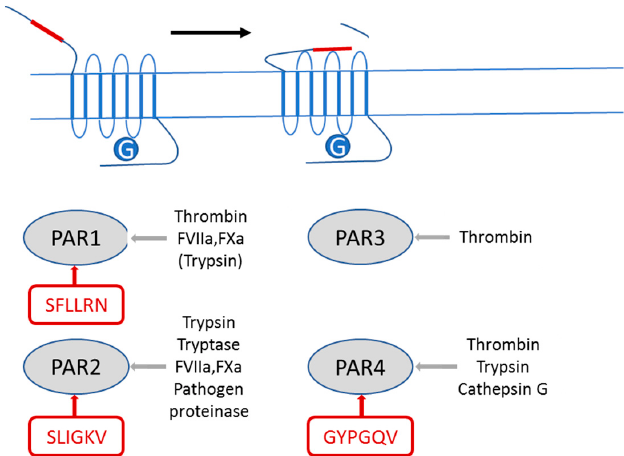
Figure 1. Diagram illustrating the mechanism of activation of proteinase-activated receptors (PARs) by proteinases and agonistic peptides. Each member of the family, PAR1, PAR2, PAR3 and PAR4, is activated by the indicated serine proteinases (in grey). Alternatively, each PAR may be activated in a cleavage-independent manner by peptide sequences (boxed in red) from its tethered ligand region (red lines in the cartoon at the top).